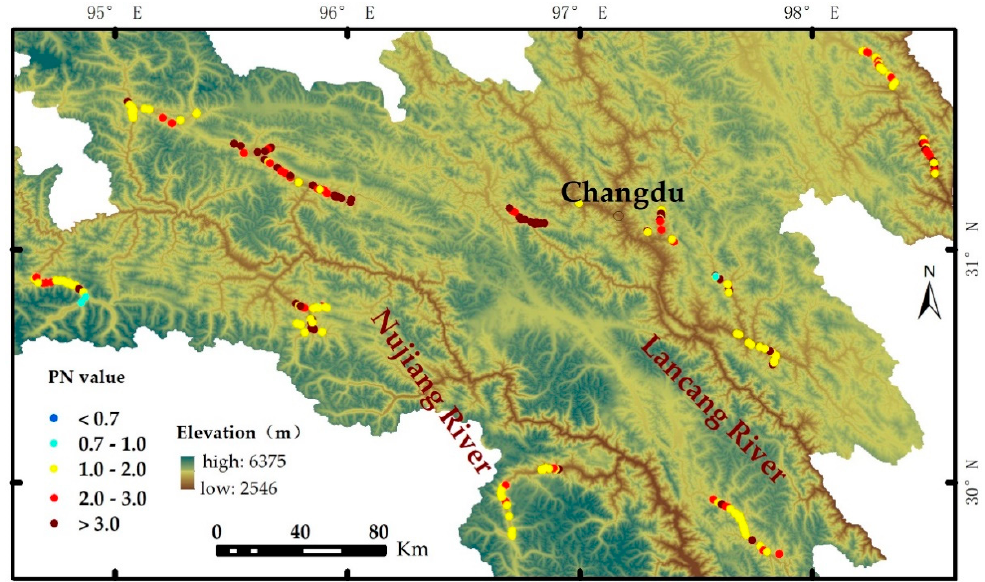
Figure 4. Interpolated PN values of the Nemero synthesis index.